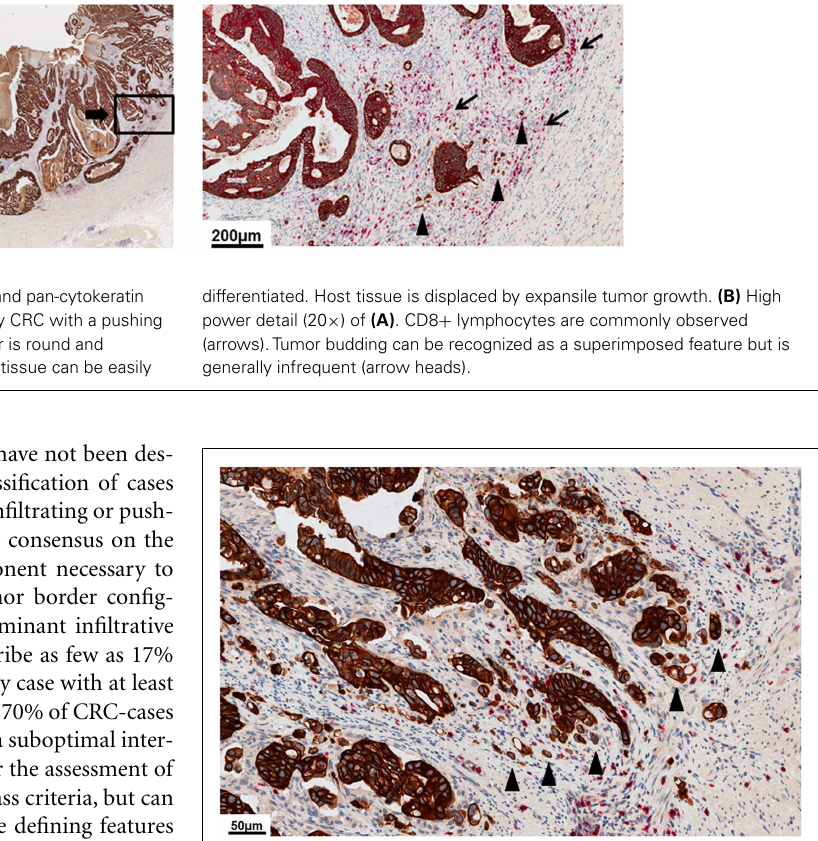
FIGURE 3 | High power image (40 × ) of a pan-cytokeratin (brown)/CD8 (red) double stain illustrating dense tumor budding at the tumor invasive front .Tumor buds (arrow heads) are defined as single cells or small clusters of up to five cells ahead of the tumor invasive front. High-grade tumor budding is a feature of aggressive biological behavior in colorectal cancer. Even though tumor budding is more frequently observed in cases with an infiltrative tumor border configuration, this is an independent feature observed at high power and must not be used to define the quality of the tumor